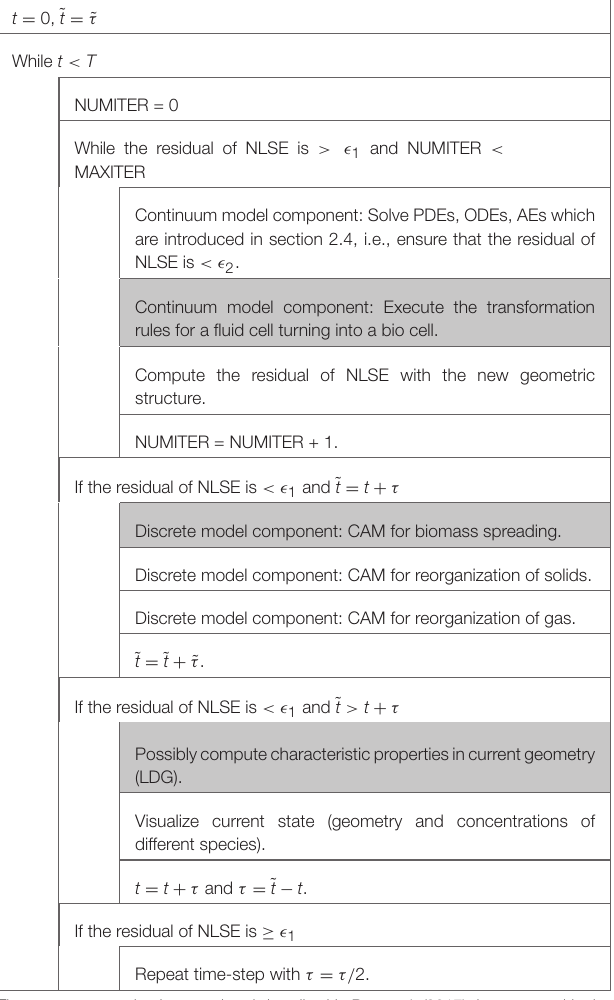
TABLE 1 | Algorithm for discrete-continuum model. t = 0, ˜ t = ˜